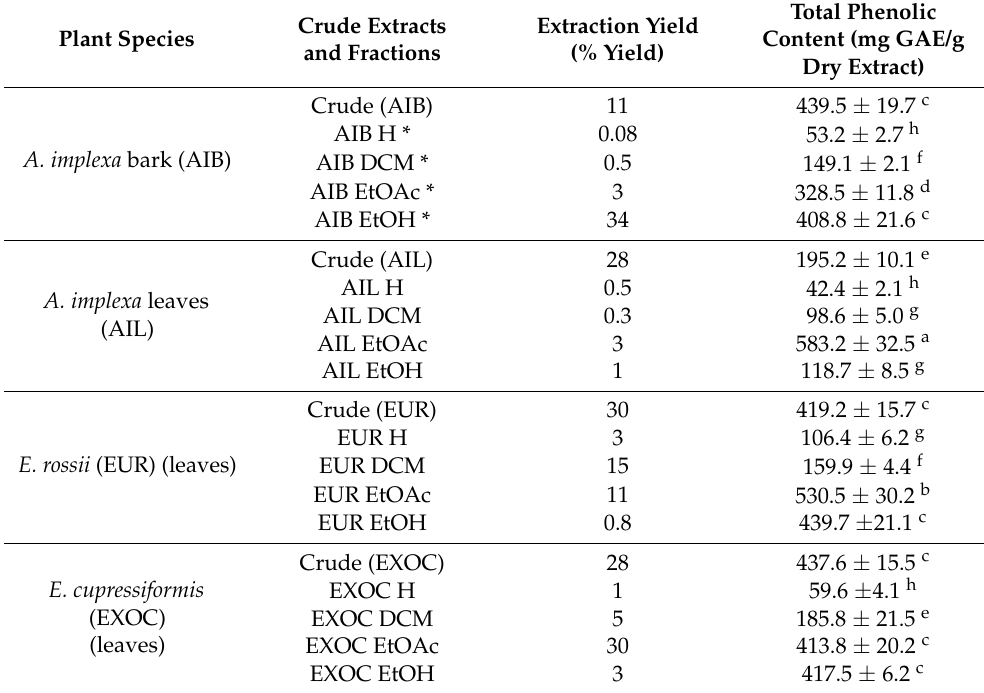
Table 1. Extraction yield and total phenolic content of crude extracts and fractions of crude extracts. Different letters in the same column show significant difference at p < 0. 05 (Tukey’s honest significant difference (HSD) post hoc test). Data are expressed as mean ±